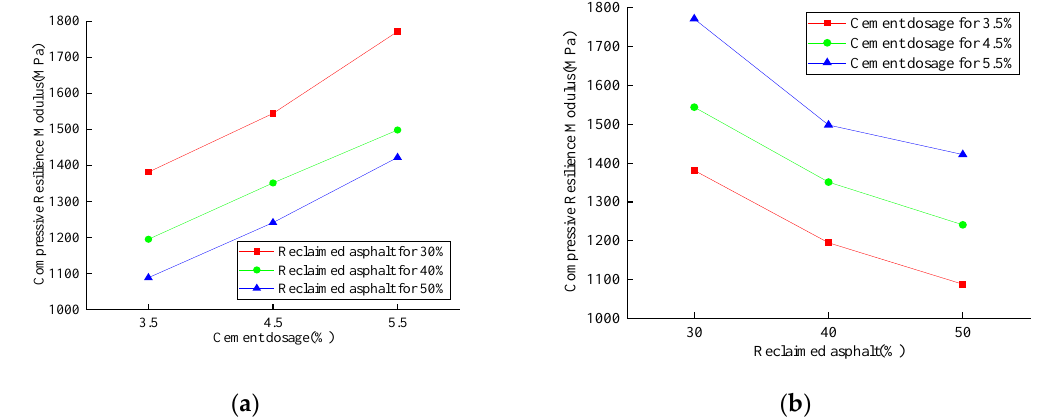
Figure 15. Results for the 28-day compressive-resilience modulus test: ( a ) cement dosage variation; ( b ) RAP replacement ratio.